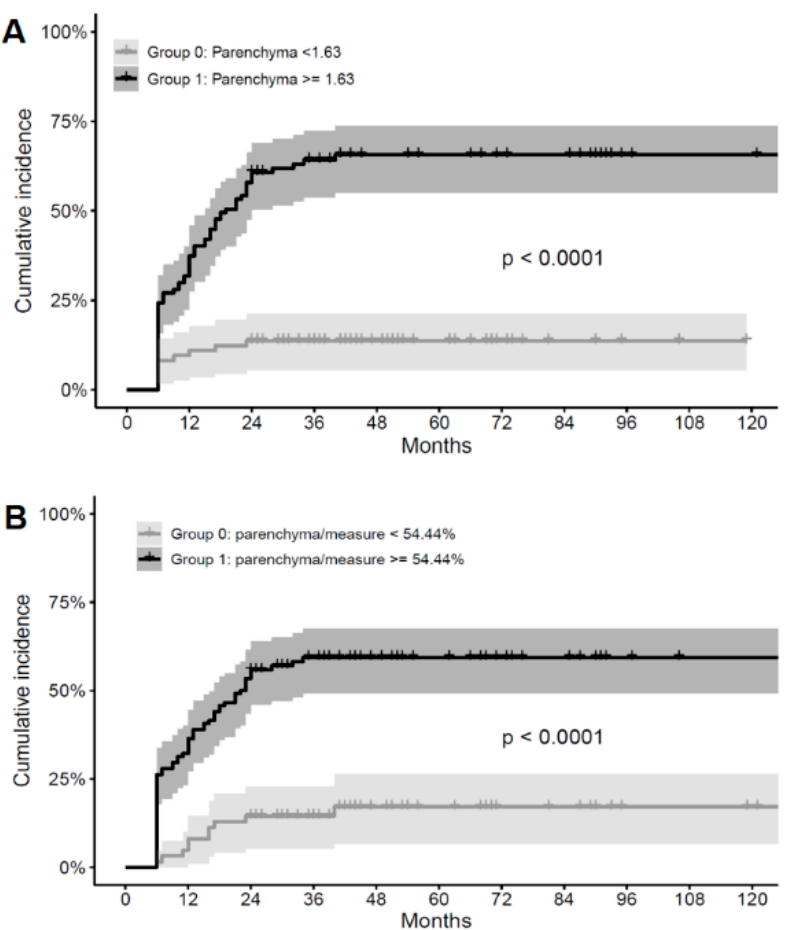
Figure 3. The cut off value of parenchyma where the Kaplan–Meier curve of RICs is most maximized. ( A ) The cut off value of parenchyma within the 50% isodose line (IDL) where the Kaplan–Meier curve of RICs is maximal: 1.63 cc. ( B ) The cut off value of the proportion of parenchyma within the 50% IDL where the Kaplan–Meier curve of RICs is most maximized: 54.4%.